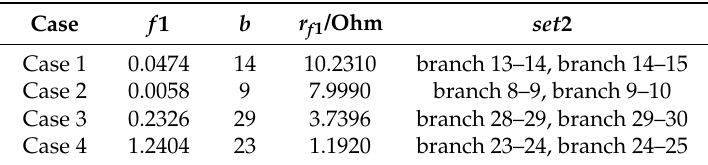
Table 3. Optimal solutions of f1 in searching the ne-node